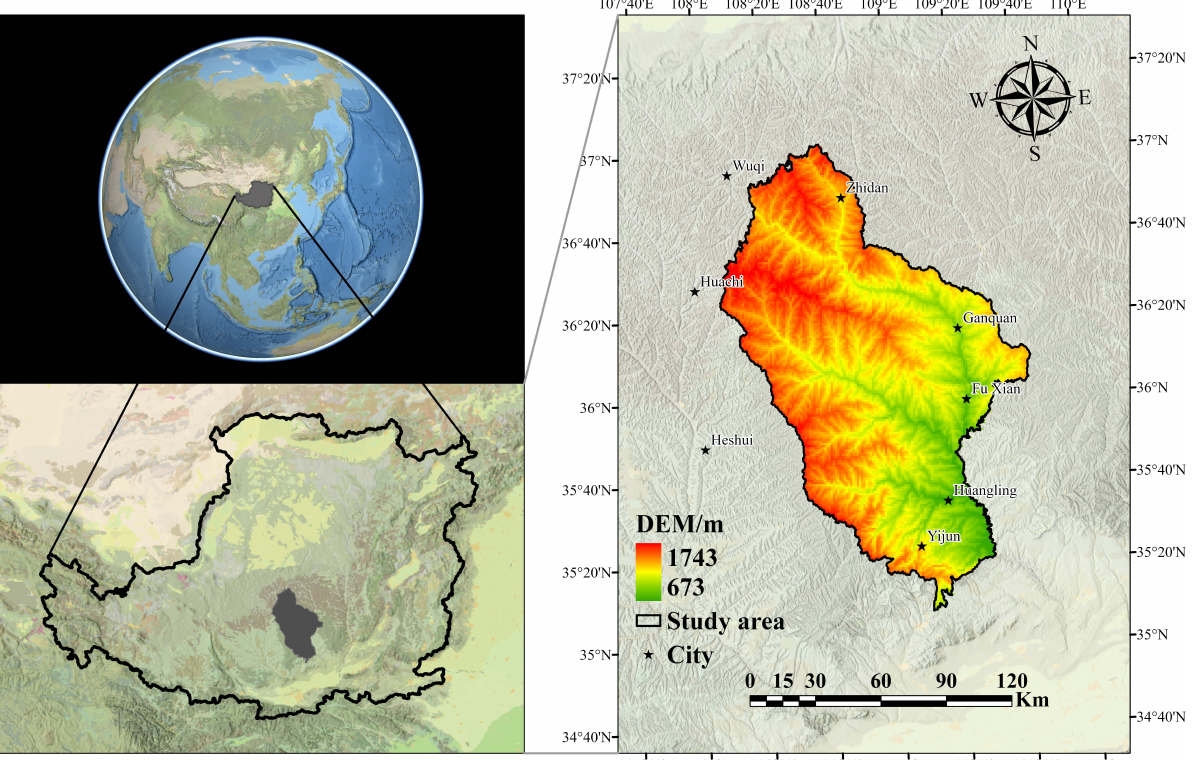
Figure 1. Ziwuling study area on the Chinese Loess Plateau.